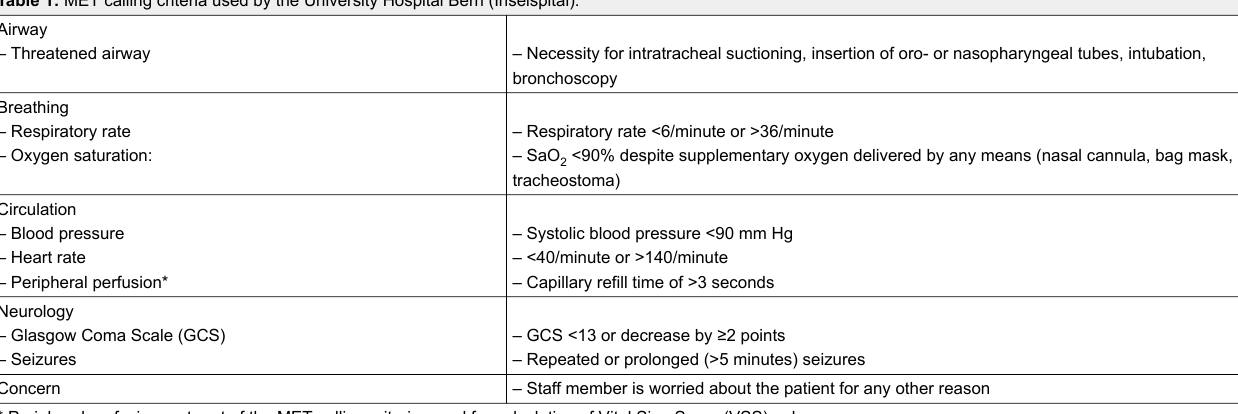
Table 2: Patient